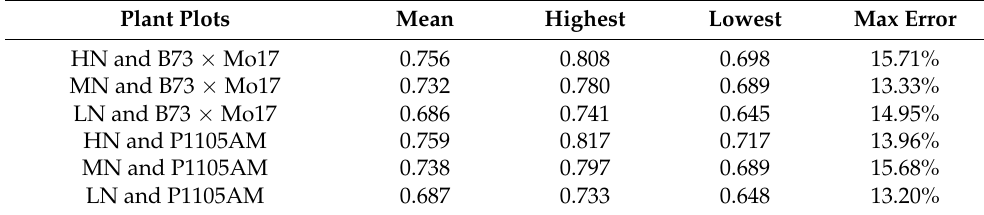
Table 3. Statistical analysis of the NDVI at Day 1 for six plant plots.